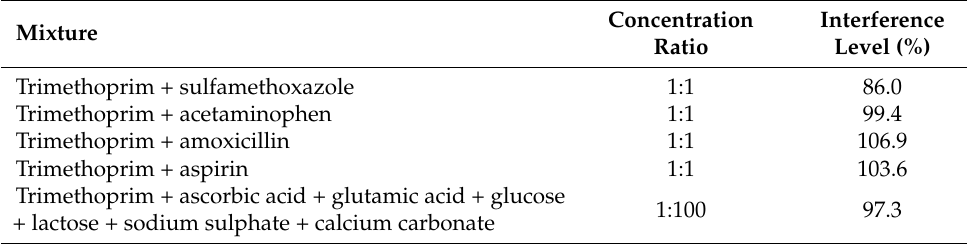
Table 2. Selectivity assessment of the carbon paper sensor in the analysis of